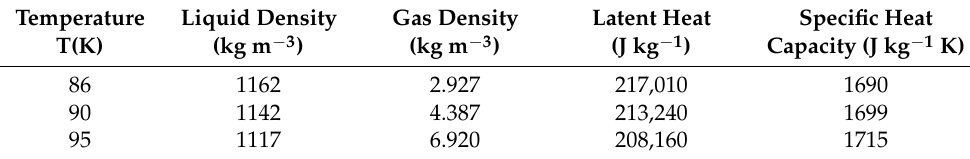
Table 6. Relevant parameters of liquid oxygen in a saturated